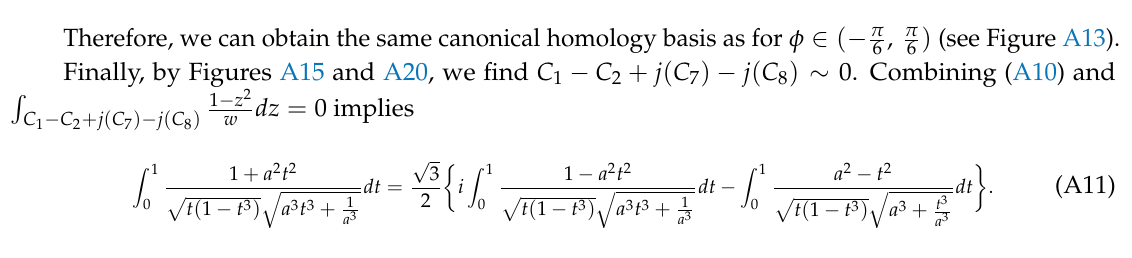
Figure A20. C 1 , C 7 in M